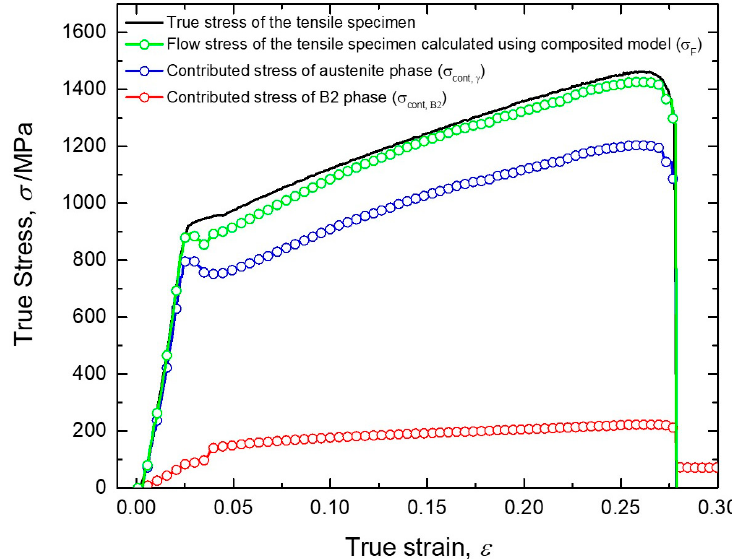
Figure 8. The contributed flow stress of the austenite phase and B2 phase, and the flow stress calculated using a composited model, are plotted as a function of the tensile true strain. The experimental tensile true stress-strain curve is also plotted. A good agreement is noticed between the calculated flow stress and the experimental flow stress.